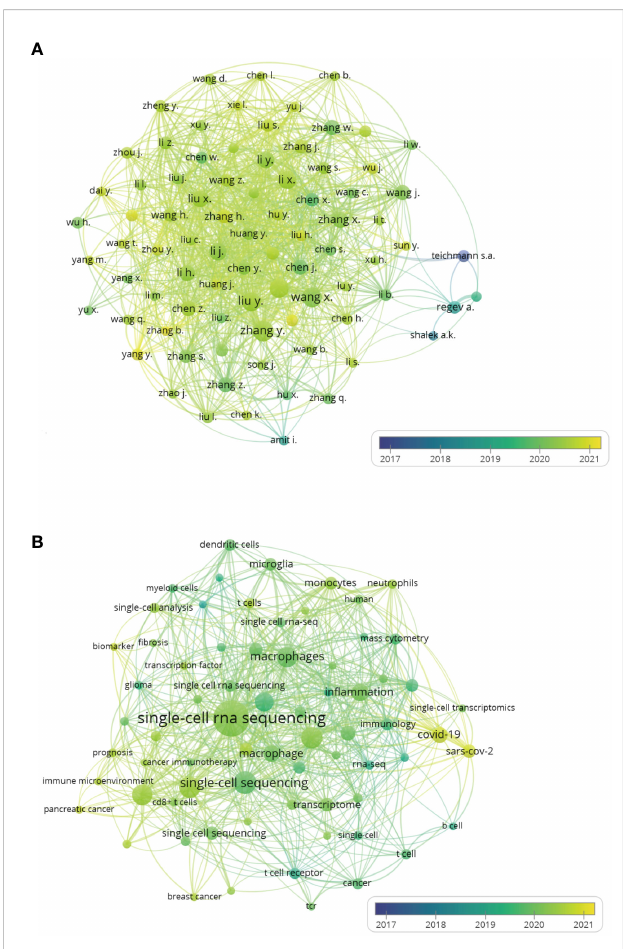
FIGURE 3 The author co-authorship and author keyword co-occurrence overlay visualization maps of single-cell sequencing publications on immune cells. (A) Author co-authorship overlay visualization maps. An author is represented by a circle, the number of publications of an author is represented by the size of the circle. The line represents the cooperative relationship between authors. The thickness of the line represents the degree of cooperation between authors. (B) Author keyword co- occurrence overlay visualization maps. The size of each circle indicates the frequency of occurrence of the author keyword. The distance between any two circles indicates their co-occurrence link, and the thickness of the connecting line indicates the link strength. The color of all circle is based on the average publication